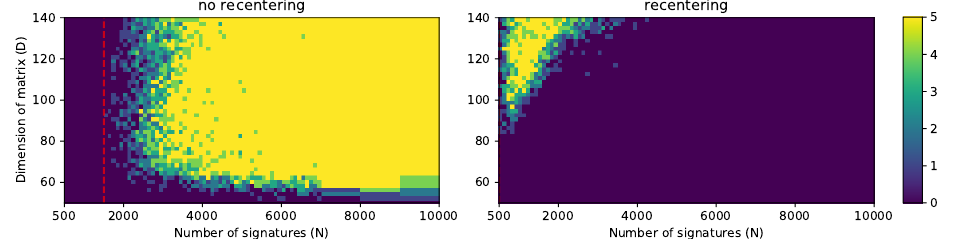
Figure 18: Heatmap of success rate (out of 5 tries) for recentering with biased bounds. Geometric bounds were used as if N = 4 d , which lead the bounds to be overly conservative for large N .